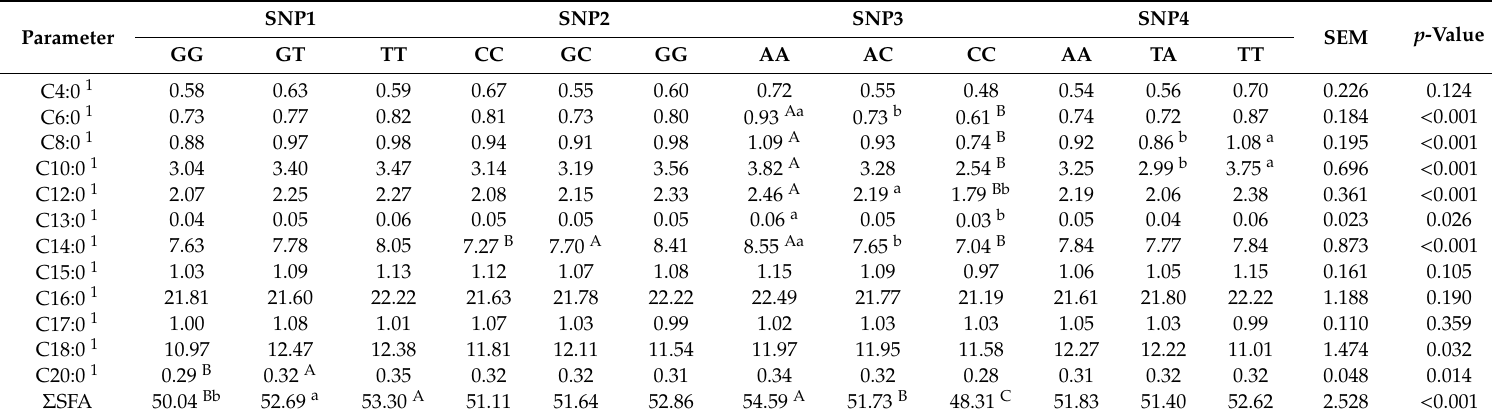
Table 5. Saturated fatty acids content in milk from Zošl’achten á valaška sheep in relation to particular genotypes of SLC27A3 gene polymorphisms. Parameter